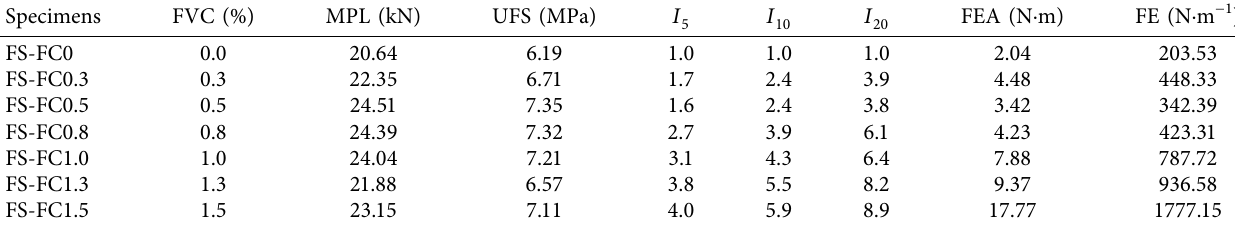
Table 4: ARGFRC fexural toughness index.